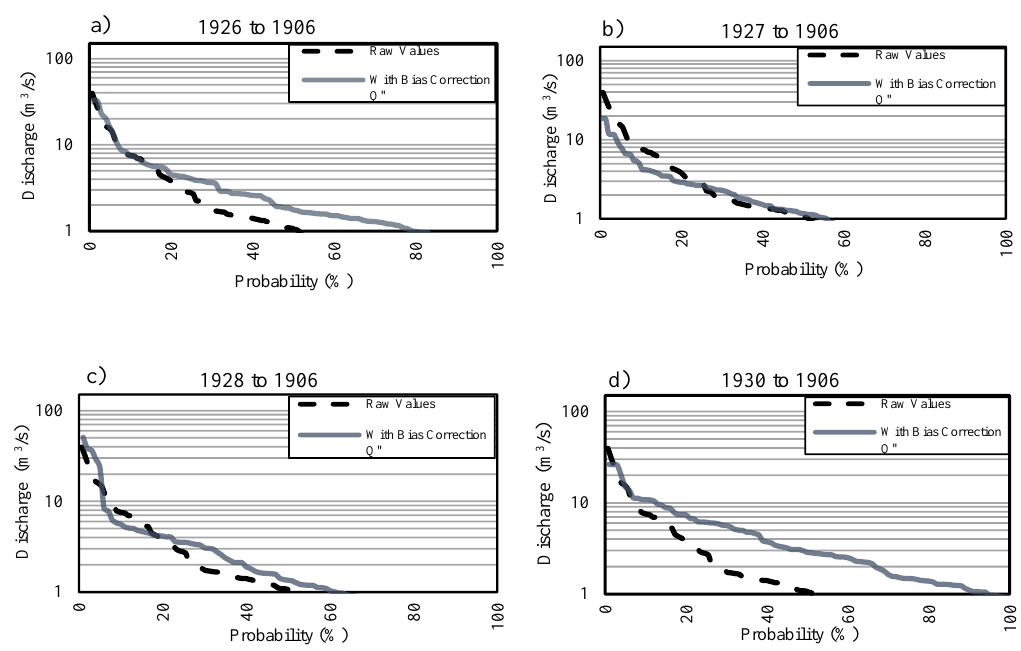
Figure 4. Flow duration curves for the number 1906 SGS. ( a ) 1926 to 1906, ( b )1927 to 1906, ( c ) 1928 to 1906, ( d ) 1930 to 1906.